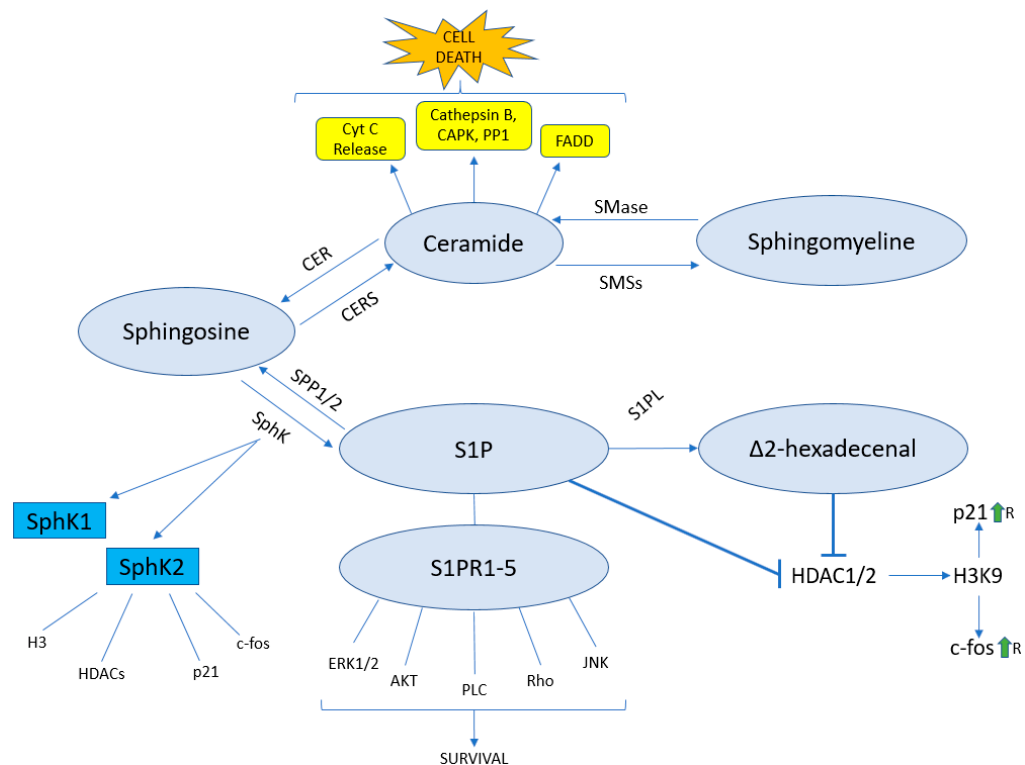
Figure 2. Schematic representation of the sphingolipid pathway. Sphingomyelin is converted by sphingomyelinase into ceramide, which then can induce cytochrome C release and increase expression of cathepsin B, CAPK, PP1 and FADD, resulting in cell death. Ceramidase converts ceramide into sphingosine, which can either be reconverted into ceramide via ceramide synthases, or be phosphorylated to S1P by sphingosine kinases. S1P mediates its cell survival effects by interacting with g-protein-coupled receptors S1PR1-5, resulting in activation of several pathways, and by inhibiting HDACs 1 and 2, increasing H3K9 acetylation and upregulating target genes. S1P is cleaved by S1P lyase into Δ 2-hexadecenal, which might also be capable of inhibiting HDACs 1 and 2.